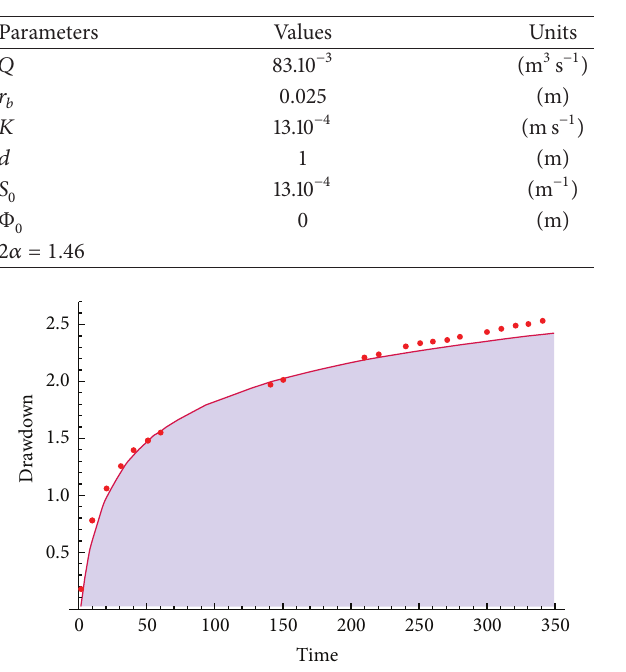
Table 1: Aquifer parameters used in the model.